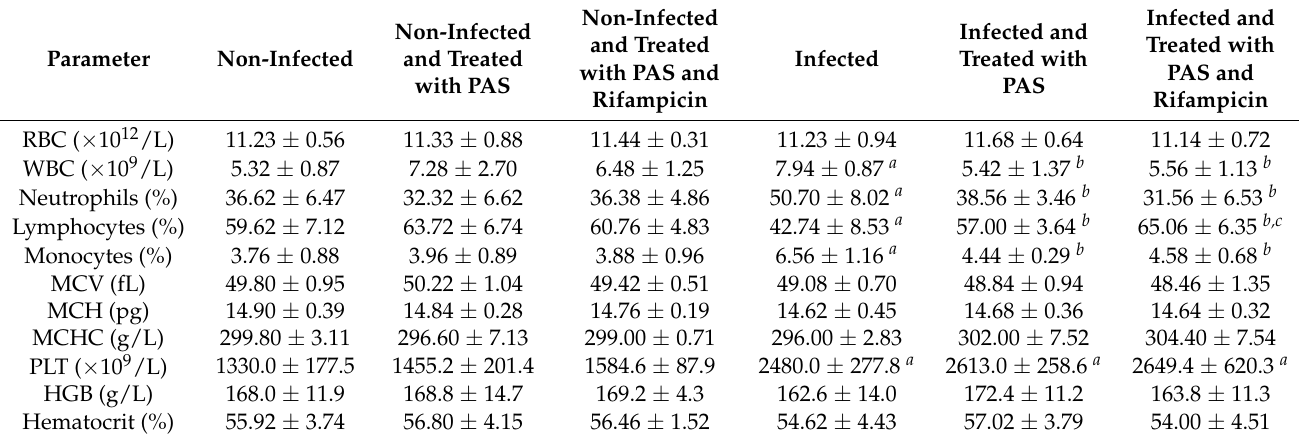
Table 1. Effects of PAS on hematological parameters in mice.